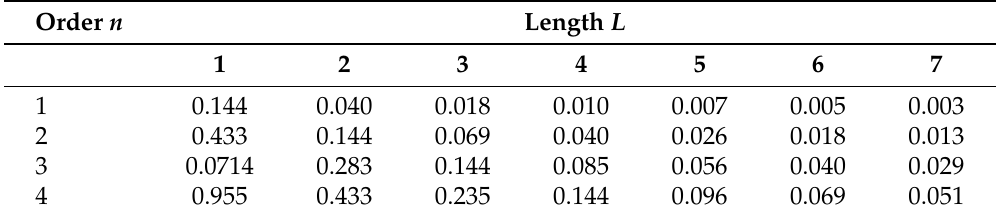
Table 5. Maximum difference between the linear and lowest-order non-linear approximations of the deformation of the buckled pinned beam for several lengths of the beam and for the first four orders of the buckling load. The parameter b is equal to 0.1. The results are multiplied by